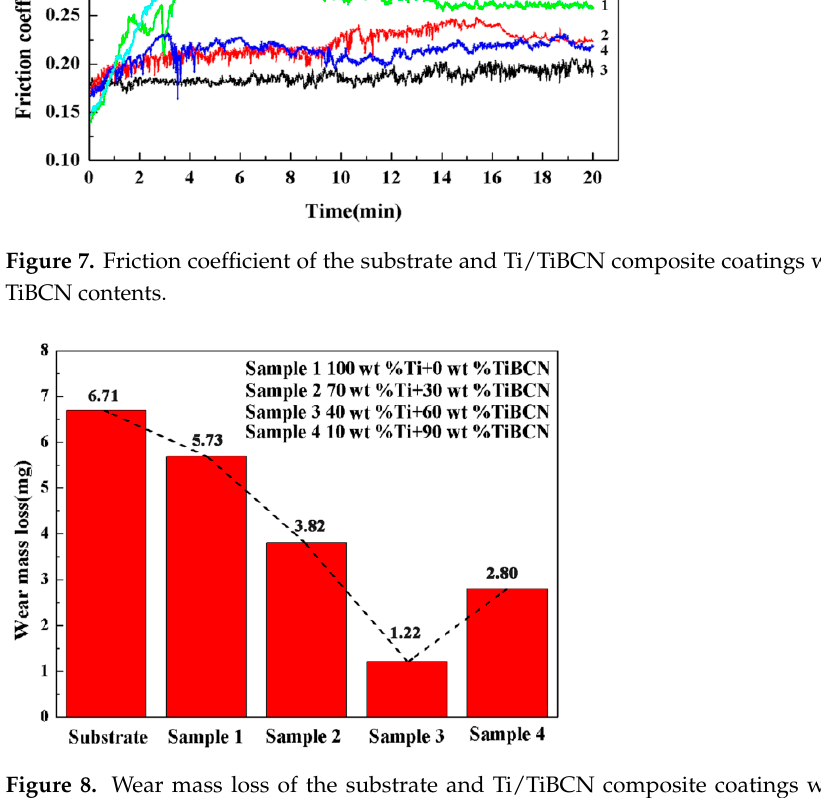
Figure 8. Wear mass loss of the substrate and Ti/TiBCN composite coatings with the different TiBCN